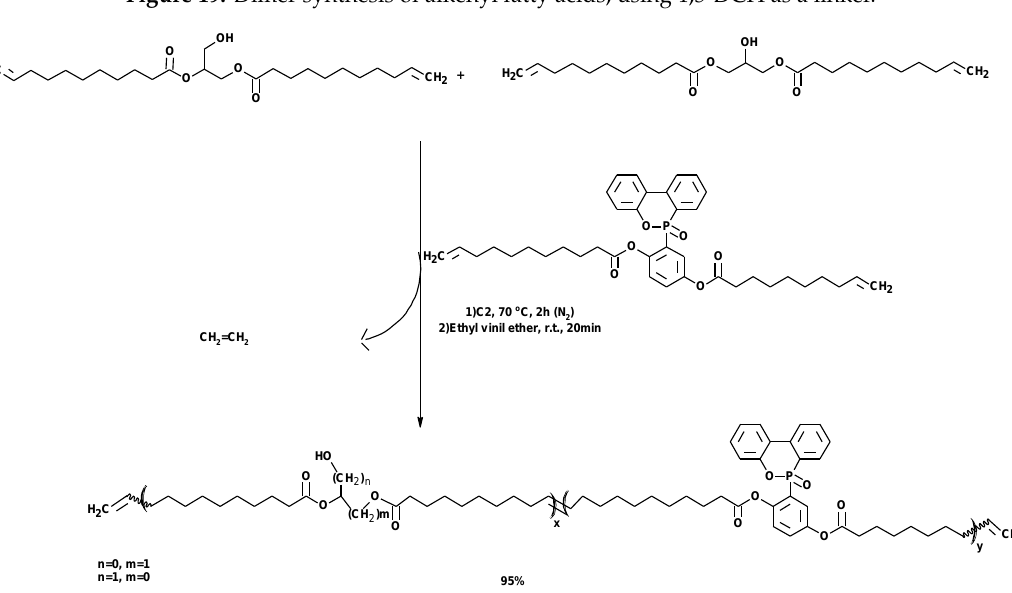
Figure 20. Synthesis of phosphorus-containing polyesters via ADMET copolymerization in presence of Grubbs 2nd generation catalyst (C2).